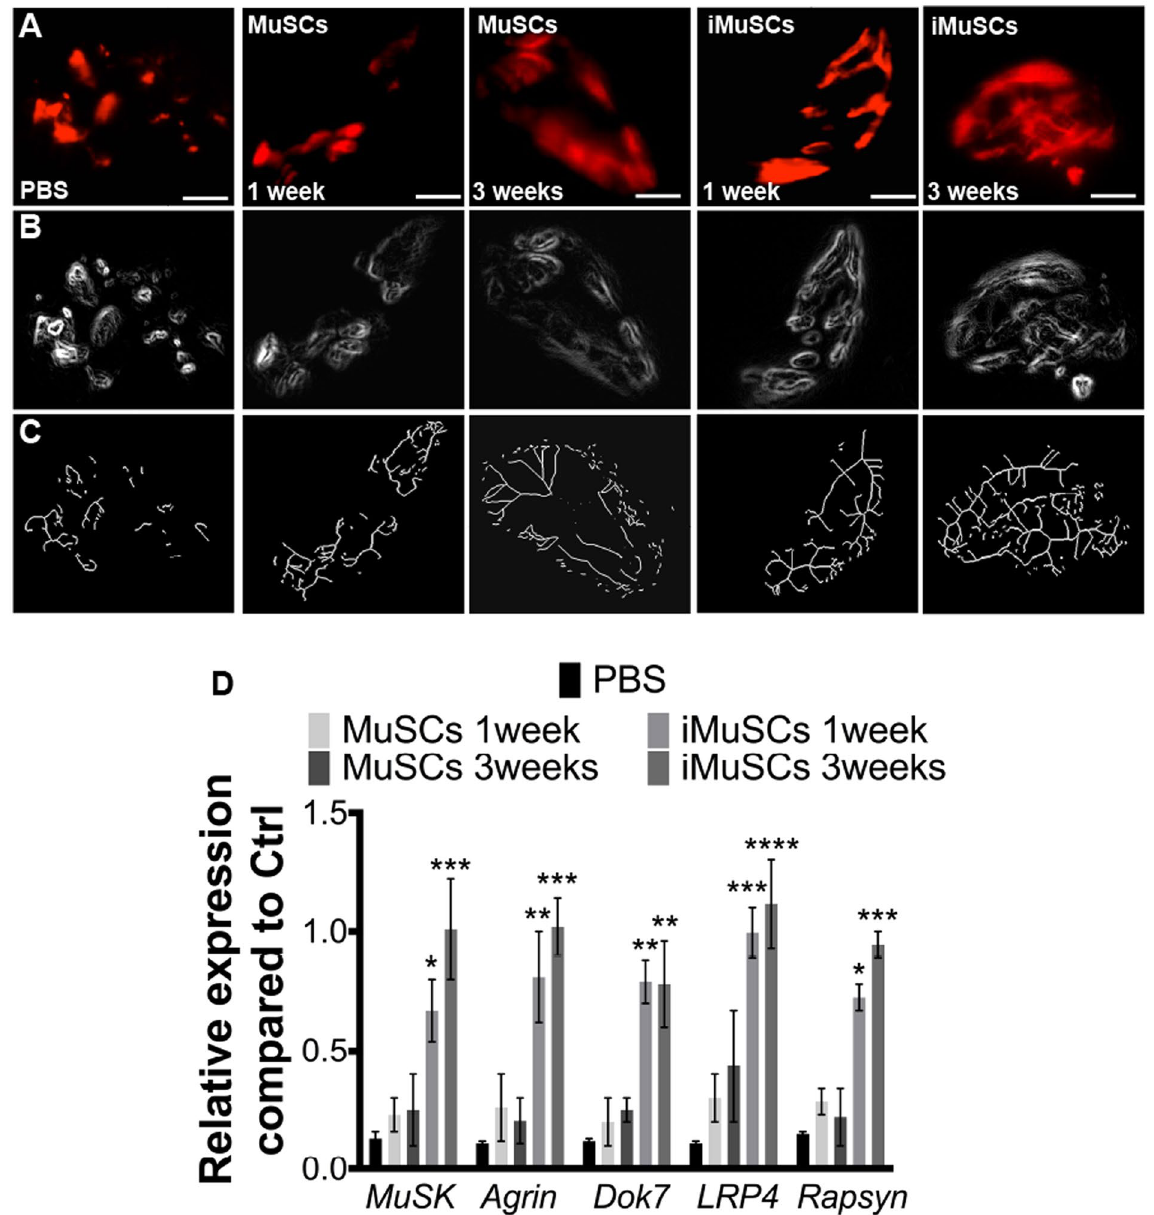
Figure 6. NMJ recovery after transplantion of iMuSCs into mdx mice. ( A ) Representative IF images of NMJs after treatment of GMs with no cells, MuSCs, and iMuSCs in mdx mice (red, A ). ( B ) Processed binary images and ( C ) skeletonized images show discontinuity and branching patters. ( D ) Expression of MuSK complex constituents. Data are presented as mean ± SEM of five biological replicates. * P < 0.05, ** P < 0.01, *** P < 0.001, **** P <